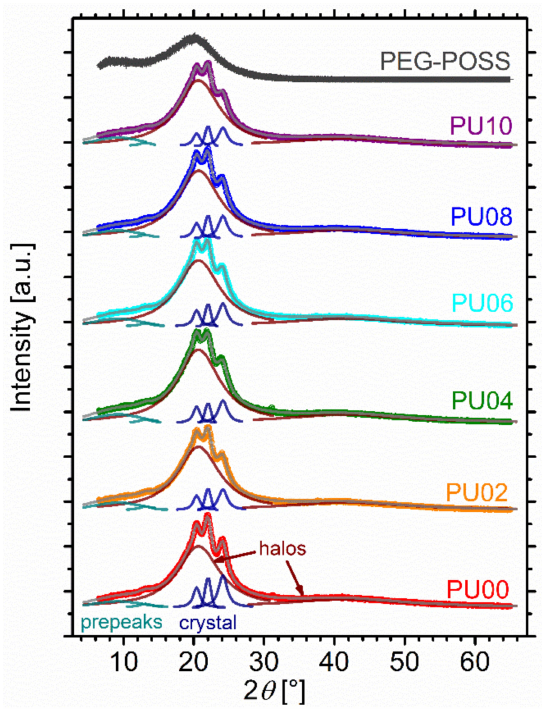
Figure 3. X-ray diffraction curves recorded with all materials under investigation. Gray lines are fits according to the procedure described in the text. The constituting peaks are shown incolors according to their origin. The diffractogram of PEG-POSS is added for